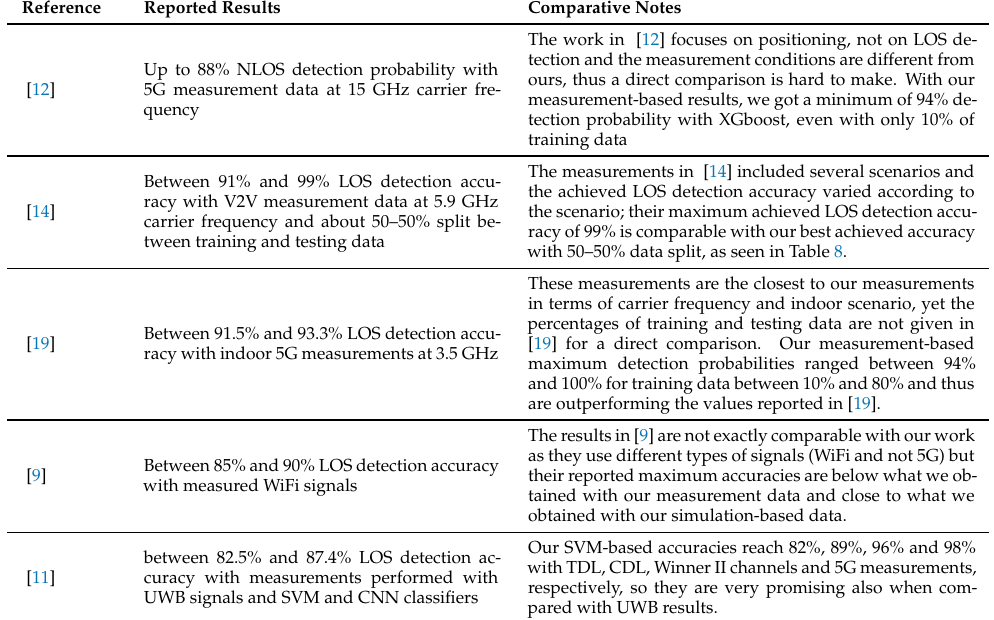
Table 9. Comparison with other results from the literature about LOS detection with 5G signals.